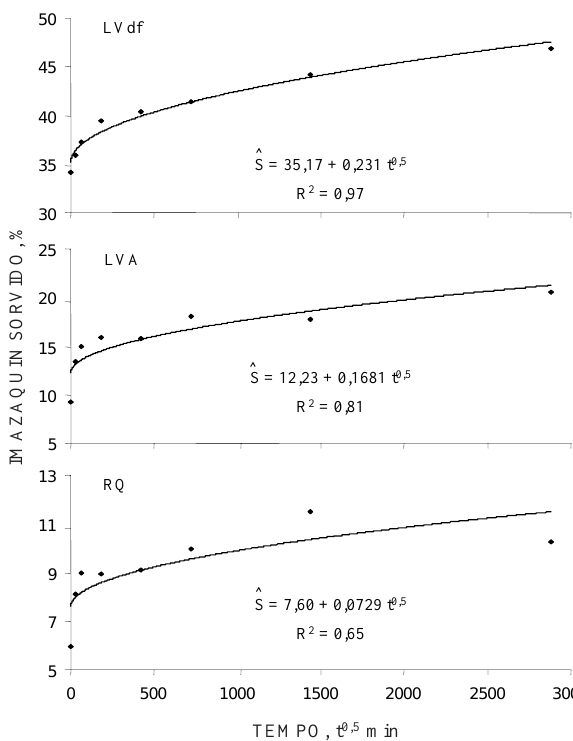
Figura 4. Percentual de imazaquin aplicado que foi sorvido em função da raiz quadrada do tempo de equilíbrio em amostras de Latossolo Verme- lho distroférrico (LVdf), Latossolo Vermelho Amarelo (LVA) e Neossolo Quartzarênico